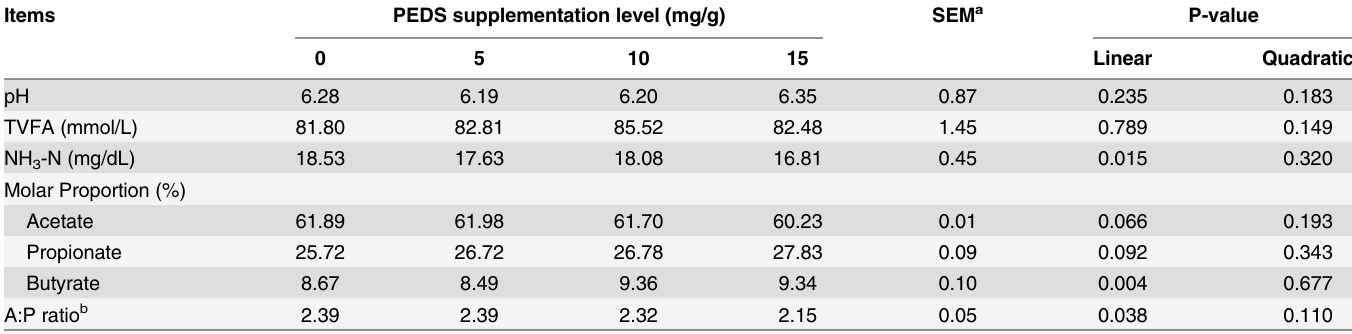
Table 4. The effects of PEDS on pH and rumen fermentation traits in continuous-culture.